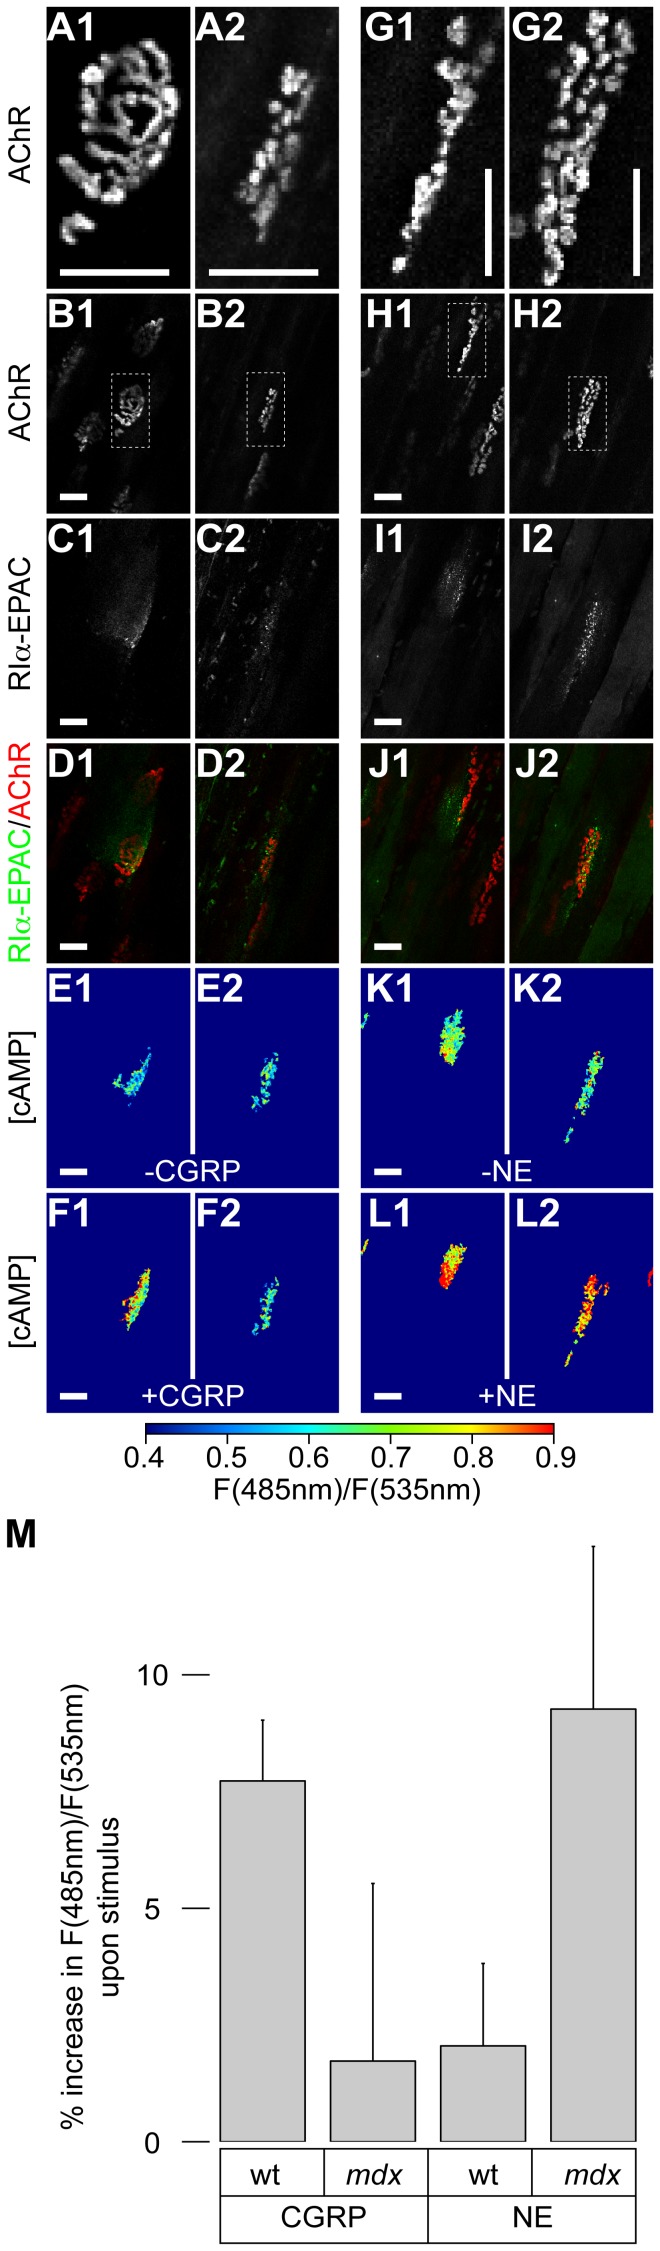
Response to cAMP agonists differs between wildtype and mdx synapses. Tibialis anterior muscles of wildtype and mdx mice were transfected with RIα-EPAC.Ten days later, muscles were injected with BGT-AF647 to stain NMJs and monitored with in vivo confocal (A–D, G–J) or two-photon (E–F, K–M) microscopy. Scale bars depict 50 µm. A and G: Shown are single mdx NMJs with normal (A1) or fragmented morphology (A2, G1, G2). B and H: BGT-AF647 fluorescence signals. Boxed regions are shown enlarged in A and G. C and I: RIα-EPAC fluorescence signals in the same field as in B and H. D and J: Overlays of B and C (D) and H and I (J). BGT-AF647 and RIα-EPAC signals are in red and green, respectively. E and K: Same field as in B and H showing FRET-ratios in pseudo-colors before application of CGRP or NE (indicated). F and L: Same field as in E and K showing FRET-ratio in pseudo-colors after application of CGRP or NE (indicated). M: Quantification of several experiments. Shown is the percentage of increase in CFP/YFP ratio values (F(485 nm)/F(535 nm)) compared to basal upon application of 50 µl of either 10 µM CGRP or 10 µM NE as indicated. Data represent mean ± SEM (n = 10 and n = 14 wildtype NMJs for CGRP and NE, respectively; n = 13 and n = 9 mdx NMJs for CGRP and NE, respectively).